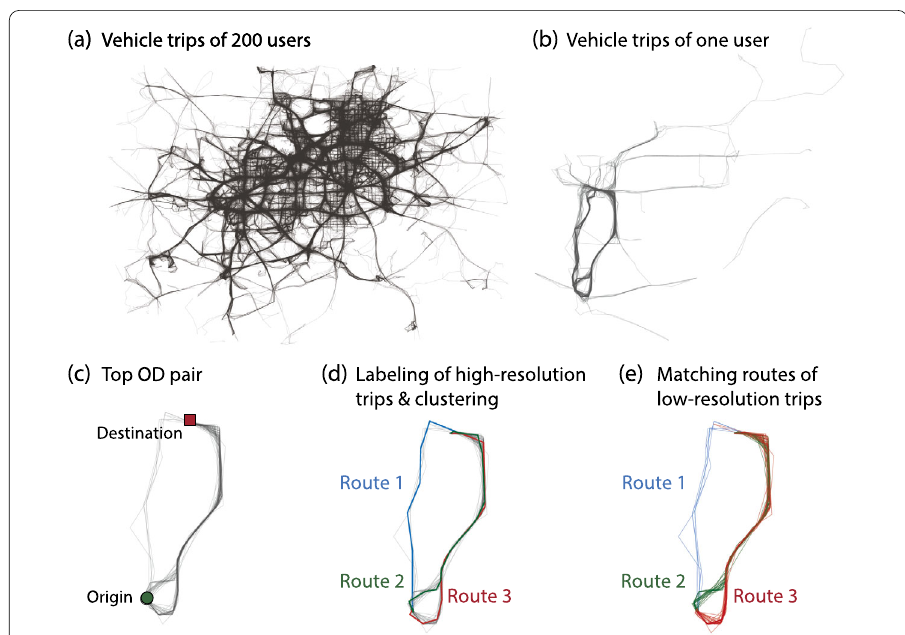
Figure 4 Route detection from the routine OD pairs. ( a ) All vehicle trips of 200 sample users. ( b ) All vehicle trips of one randomly selected user. ( c ) Trips in the top OD pair. ( d ) Routes detected from the high-resolution trips. ( e ) Matching the routes of low-resolution